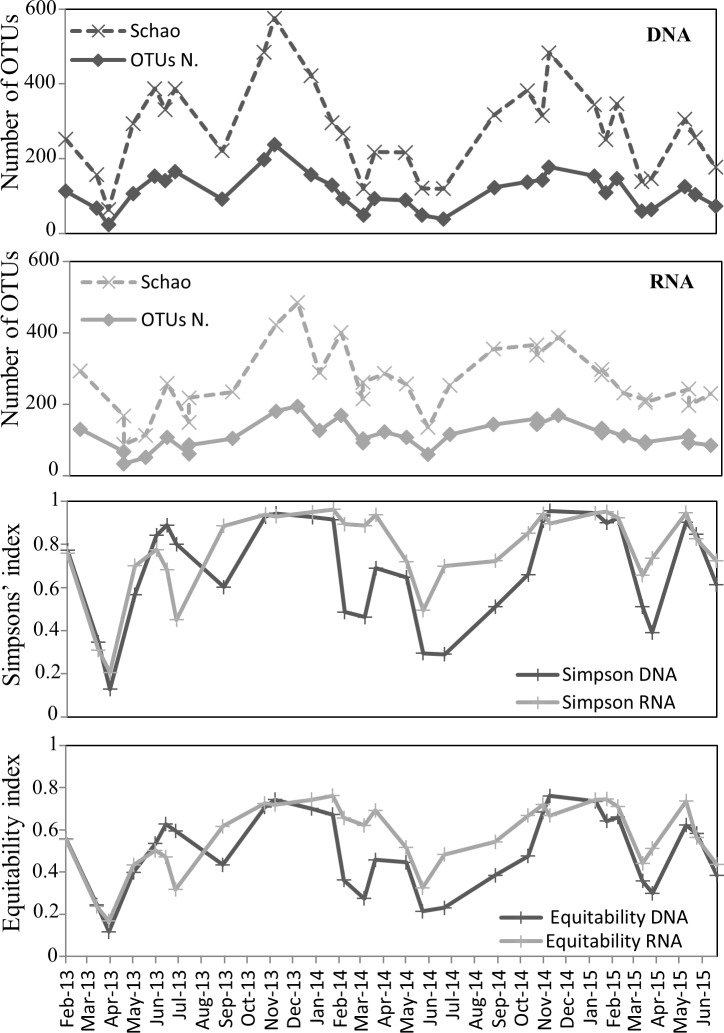
Diversity indices, based on rDNA and rRNA Illumina sequencing, for samples taken in the EEC (2013–2015).Curves represent the number of OTUs (solid lines), the richness estimator (Schao1, dash lines) and indices for diversity heterogeneity (Simpson, Equitability). The rDNA-based dataset is depicted with dark grey lines and the rRNA-based dataset with light grey lines.